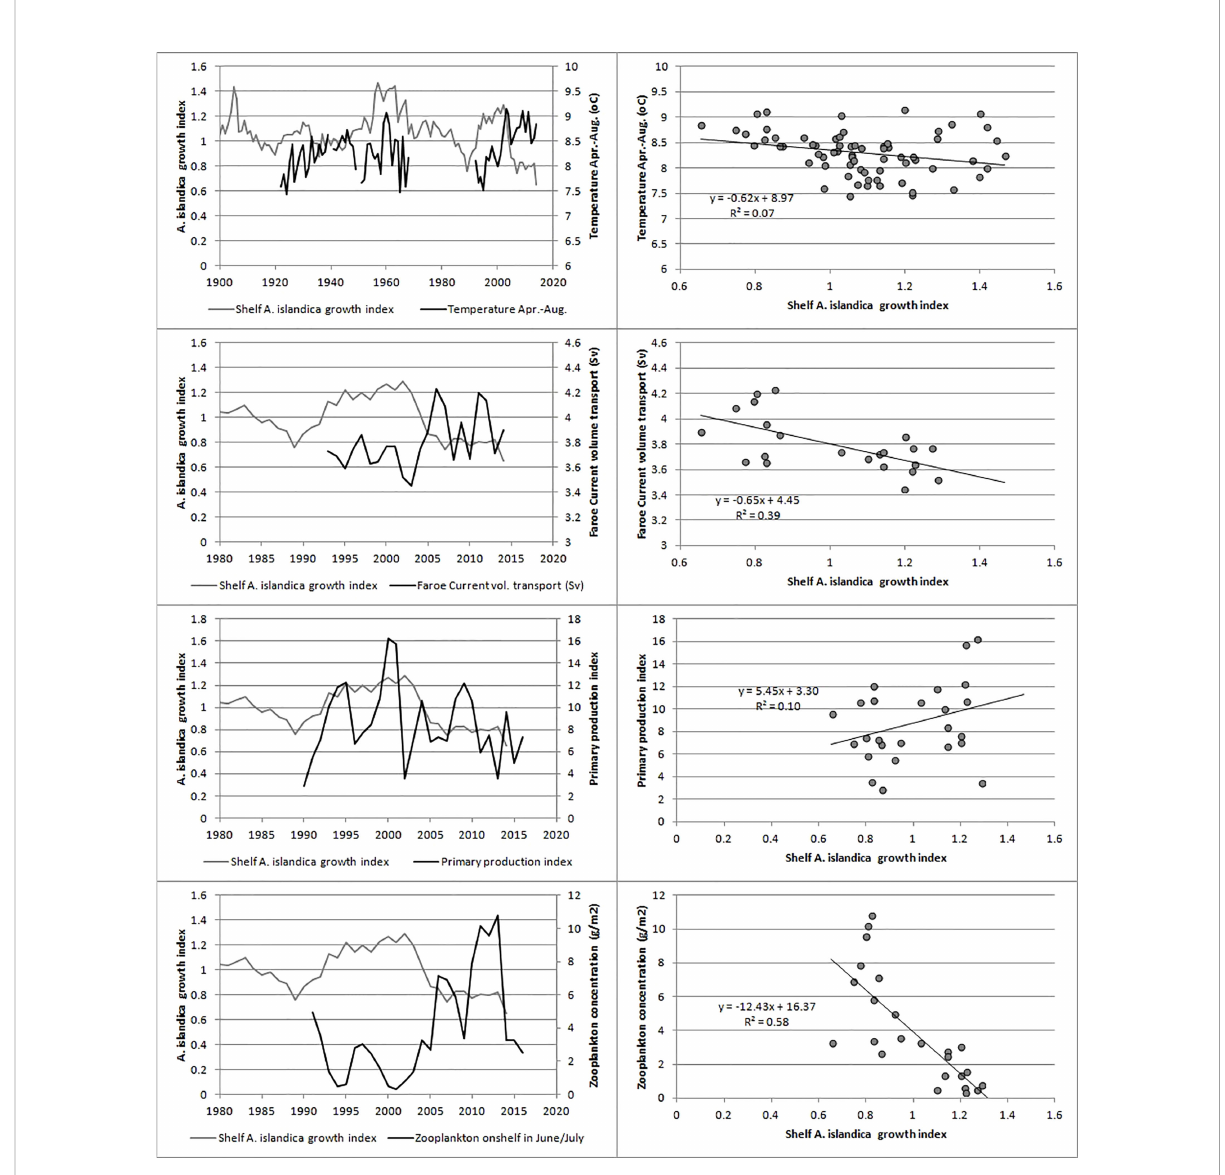
FIGURE 7 Relationship between the shelf A. islandica growth index and environmental factors shown as time series and as scatterplots. Top: sea surface temperature during April to August, upper middle: Faroe Current volume transport, lower middle: index of primary production on the Faroe Shelf, bottom: index of zooplankton biomass on the Faroe